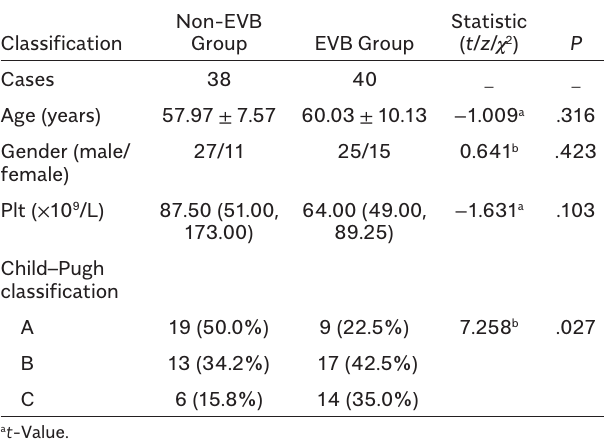
Table 3. ROC Curve Analysis of Conventional Parameters between the 2 Groups